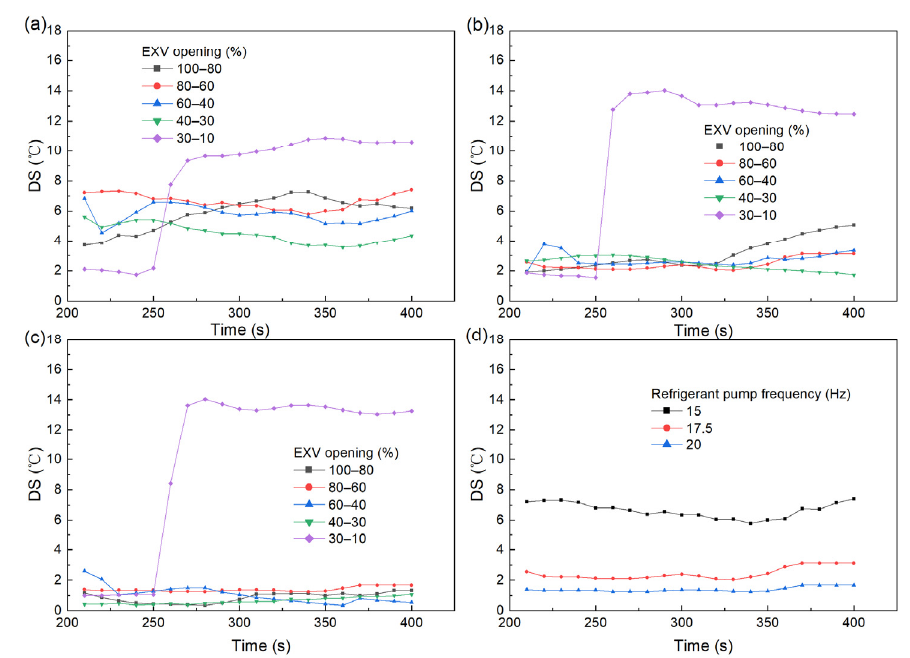
Figure 5. Change curves of DS when the refrigerant pump opening is 80% ( a ) the refrigerant pump frequency is 15 Hz, and the EXV1 opening is 100%–10%, ( b ) the refrigerant pump frequency is 17.5 Hz, and the EXV1 opening is 100%–10%, ( c ) the refrigerant pump frequency is 20 Hz, and the EXV1 opening is 100%–10%, ( d ) the EXV1 opening is 80%–60%, and the refrigerant pump frequency is 15 Hz, 17.5 Hz, and 20 Hz,